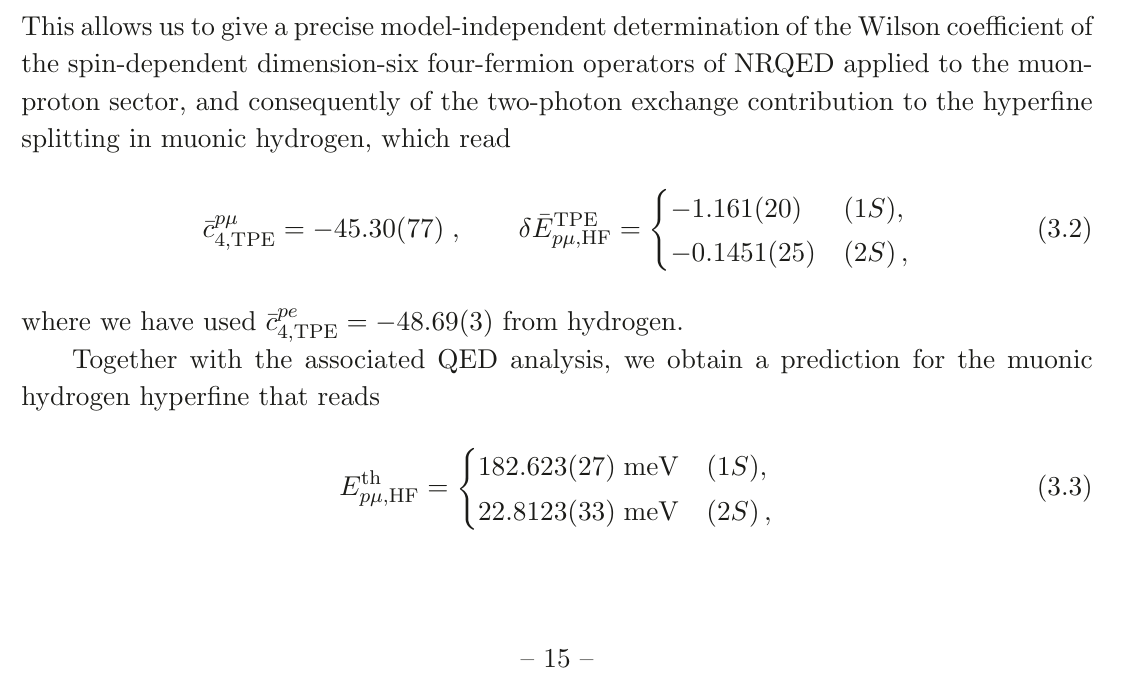
(2 S ). For details see table 3 and the main pµ, HF